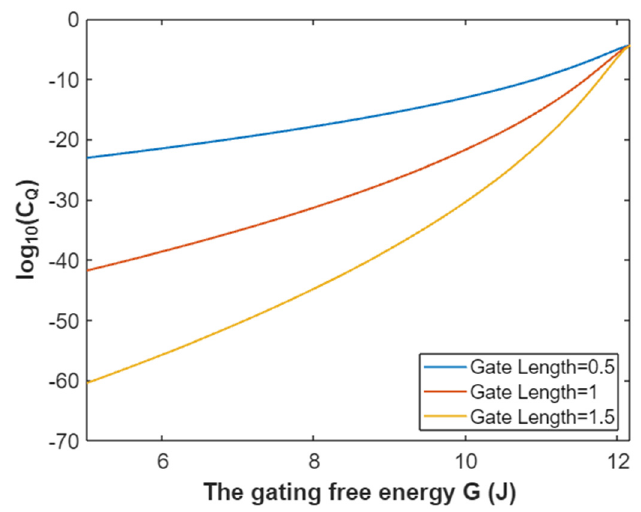
Figure 12. The relationship between gating free energy and the common logarithm of quantum